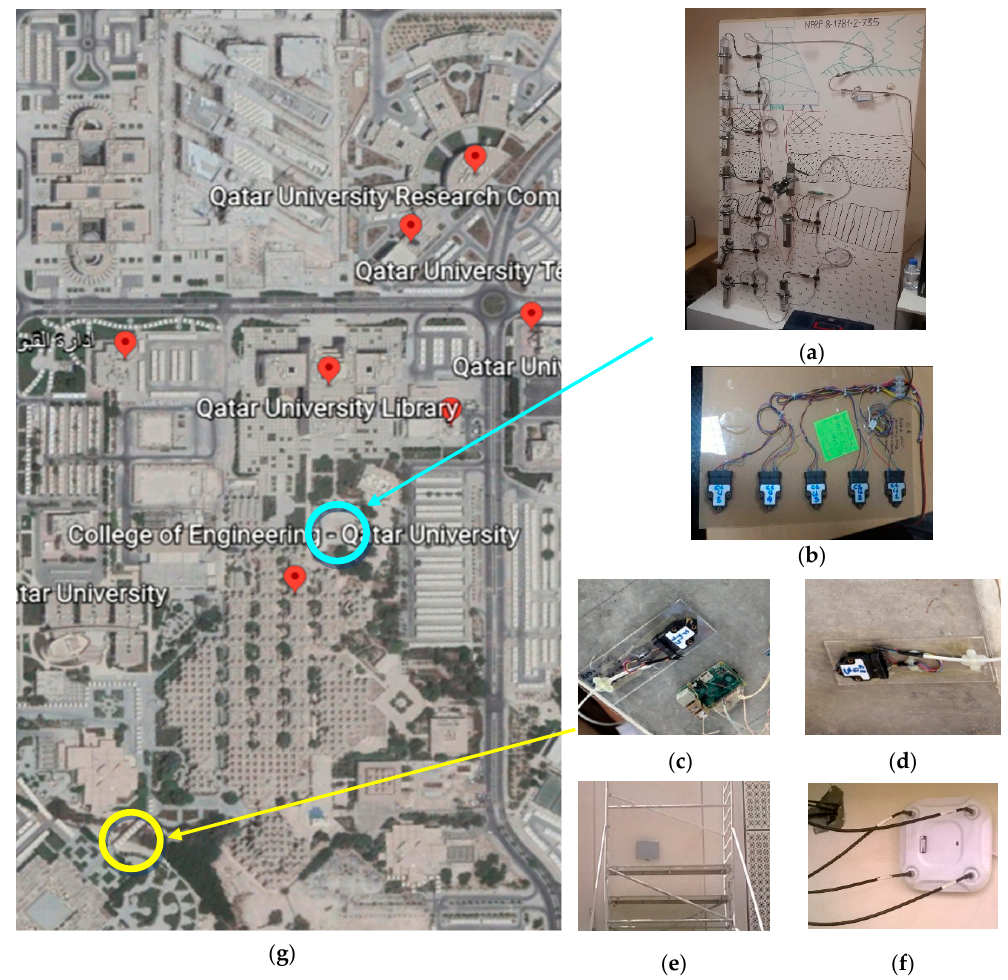
Figure 15. Case study: Qatar University (QU) SWEDA-SHM sites deployment details listed as ( a , b ) B09 Lab with 10 C-SGBINs on SHM stand and 5 F-SGBINs on table and ( c ) out-surface board (OSB) and a F-SGBINs at the QU Bridge Site; ( d ) F-SGBINs at QU Bridge Site; ( e ) Outdoor Data Unit (ODU) for QU Bridge site mounted on wall of C05; ( f ) Indoor Data Unit (IDU) for QU Bridge site mounted on wall of C05; ( g ) overview on Google Maps for QU SHM